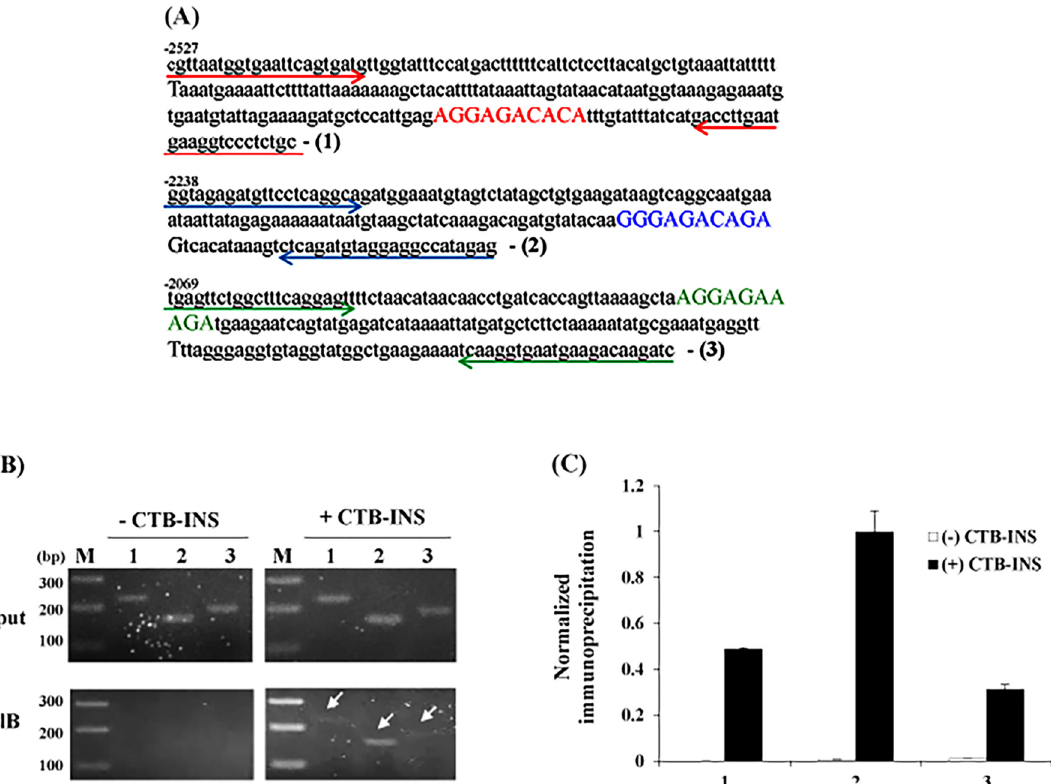
Fig 4. ChIP analysis showing vaccine stimulation of NF- κ B RelB binding to the human dendritic cell IDO1 promoter region in vivo. Panel (A) shows the sequence of three partial non-canonical NF- κ B RelB binding sites in the IDO1 promoter (bold nucleotides). The arrows indicate the primer sequences for detection of the three RelB binding sites. Panel (B) shows the PCR products after chromatin immunoprecipitation (ChIP). Immature human DCs were stimulated with the CTB-INS fusion protein vaccine for 0 (-) or 6 hr (+). Protein-DNA complexes were cross-linked, the DNA sheared and RelB genomic DNA complexes immunoprecipitated with RelB monoclonal antibody. After purification of the DNA, Real-time PCR was performed using primers flanking the three consensus NF- κ B RelB binding sites in the human IDO1 promoter region shown in panel A. The Input control consists of PCR amplification of the IDO1 promoter obtained from total genomic DNA prior to immunoprecipitation. Lane M: DNA fragment size marker, Lanes 1, 2, 3: show the products of PCR amplification with primer sets detecting the three consensus RelB binding sites in the vaccinated human IDO1 promoter region (white arrows). Panel (C) Quantification of immunoprecipitation was performed for three experiments, by normalizing the intensity of each immunoprecipitated band to its input.